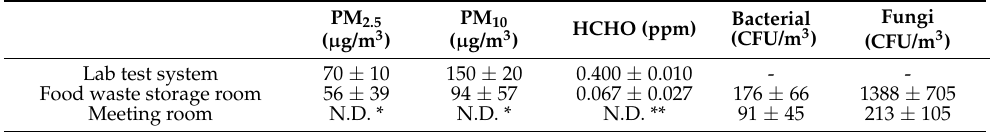
Table 2. Background of concentration in lab and field tests.